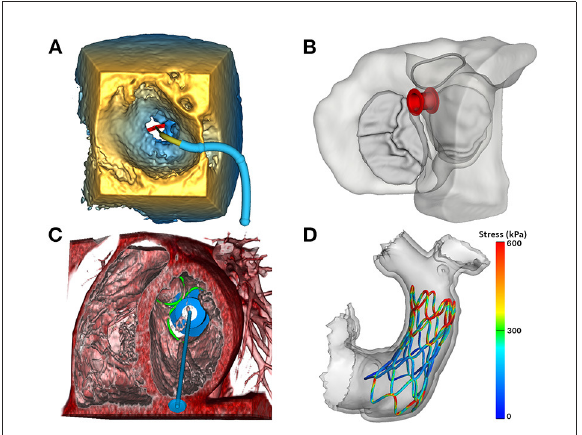
FIGURE8 Image-based modeling of transcatheter devices. (A) Demonstration of the ValveClip delivery simulator module in SlicerHeart, to model a transcatheter edge-to-edge repair within a 3DE image of a mitral valve rendered in the echo volume rendering module; (B) Visualization of an ASD closure device in segmented myocardium and valves viewed from the atrium using the ASD/VSD Device simulator module; (C)